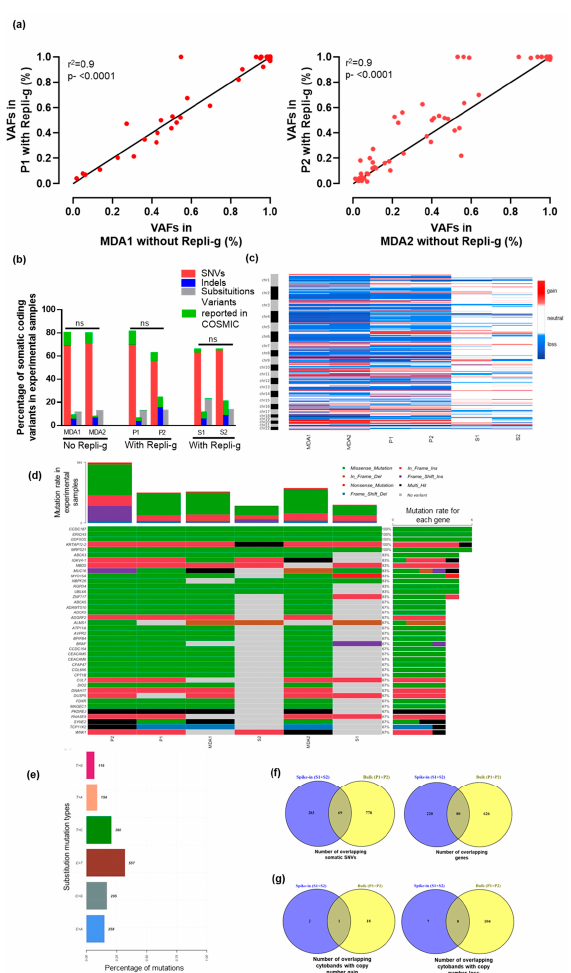
Figure 1. Overview of whole exome sequencing (WES) analysis in spike-in and unspiked breast cancer cells ( a ) Scatter plot of variant allele fractions (VAFs) detected using WES for replicate 1 and 2 of amplified and non-amplified bulk cancer MDA-MB-231 cells. For replicate 1, data points are for 133 shared variants between P1 and MDA1 (Pearson’s r 2 = 0.9) and 163 shared variants for P2 and MDA2 (Pearson’s r 2 = 0.9). ( b ) Bar graph depicting the percentage of coding variants in experimental samples (Bulk cells = MDA1 and MDA2 without Repli-g; Bulk cells = P1 and P2 with Repli-g; and, spike-in cells = S1 and S2 with Repli-g). The Mann–Whitney test was used to evaluate the di ff erences between coding variants within technical replicates. ( c ) Copy number alteration (CNA) profile heatmap for amplified (P1, P2, S1, and S2) and non-amplified samples (MDA1 and MDA2) with gain (red), loss (blue), and neutral (white). Both Repli-g amplified DNA and non-amplified DNA showed a similar pattern of copy number profiles. The Pearson r test was used for correlation analysis between amplified and non-amplified samples. ( d ) Oncoplot showing the 40 most frequently mutated genes color-coded by type of mutations in experimental samples. The percentage to the right of the oncoplot shows the percent of samples with variants for the corresponding gene. Right, barplot shows the mutation rate in each of 40 mutated genes; Top, barplot shows the mutation rate for each patient for 40 most frequently mutated genes. By default, samples are ordered by the most frequently mutated genes. ( e ) Distribution of base substitutions in experimental samples revealed a signature characterized predominantly by C > T transition substitutions. The percent mutations are shown on the x-axis and substitution mutation types are on the y-axis. ( f ) The number of overlapping somatic single nucleotide variants (SNVs) and genes in Repli-g amplified bulk MDA-MB-231 (P1 + P2) and spike-in samples (S1 + S2). ( g ) The number of overlapping chromosomes cytobands (cytogenic bands) with copy number gains and losses in Repli-g amplified bulk MDA-MB-231 (P1 + P2) and spike-in samples (S1 +